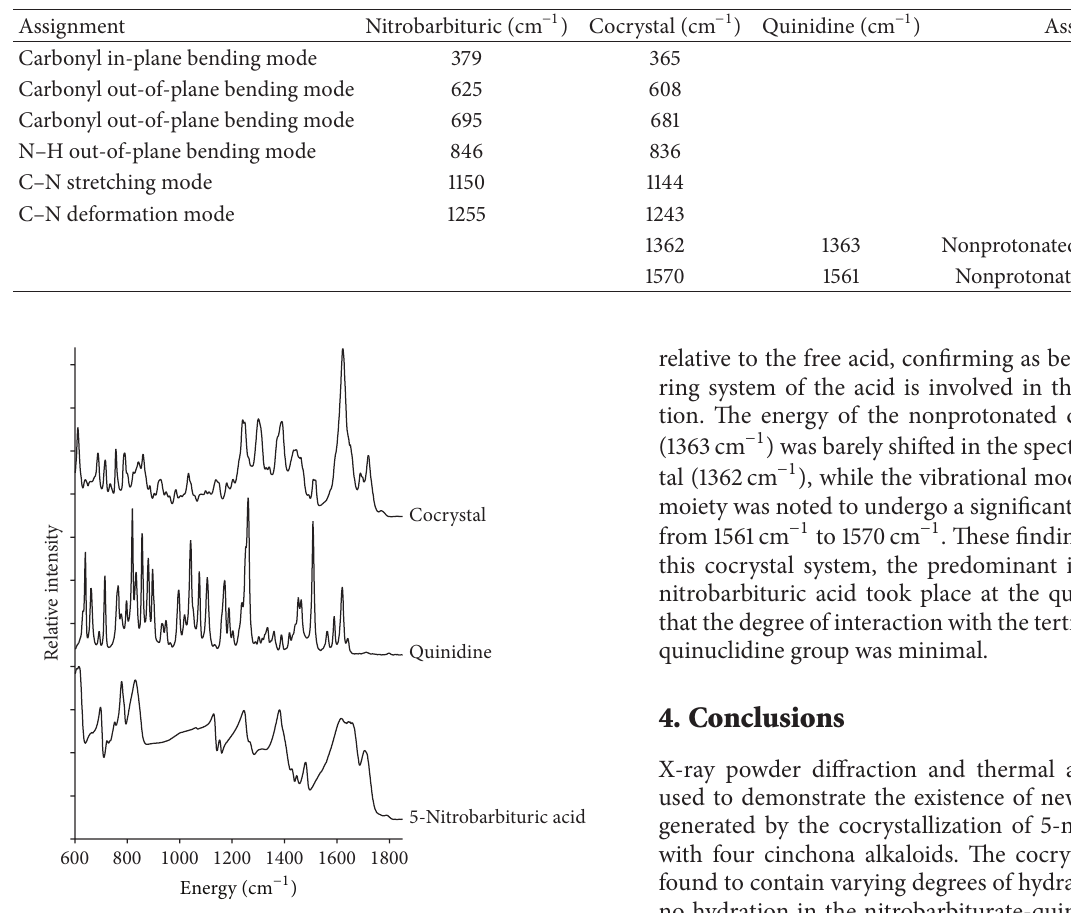
Table 8: Assignments of the major bands in the fingerprint region of the Raman spectra of 5-nitrobarbituric acid, quinidine, and their 1:1 cocrystal product.